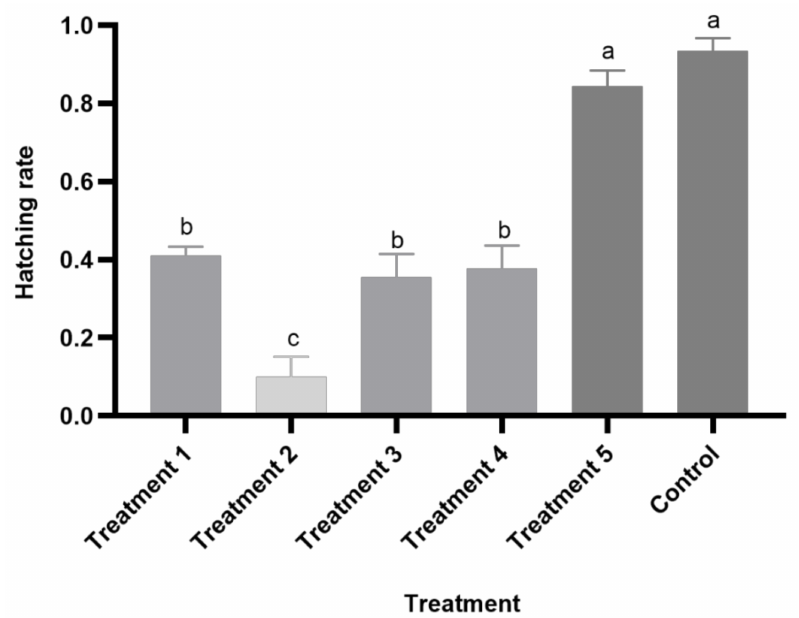
Figure 6. Effect of five variable temperature regimes on the hatching rate of Clanis bilineata tsingtauica eggs. Bars represent the standard error. The hatch rates of eggs stored at variable temperatures were analyzed using LSD. Different letters on the bars indicate significant differences ( F 5,11 = 44.43; p <